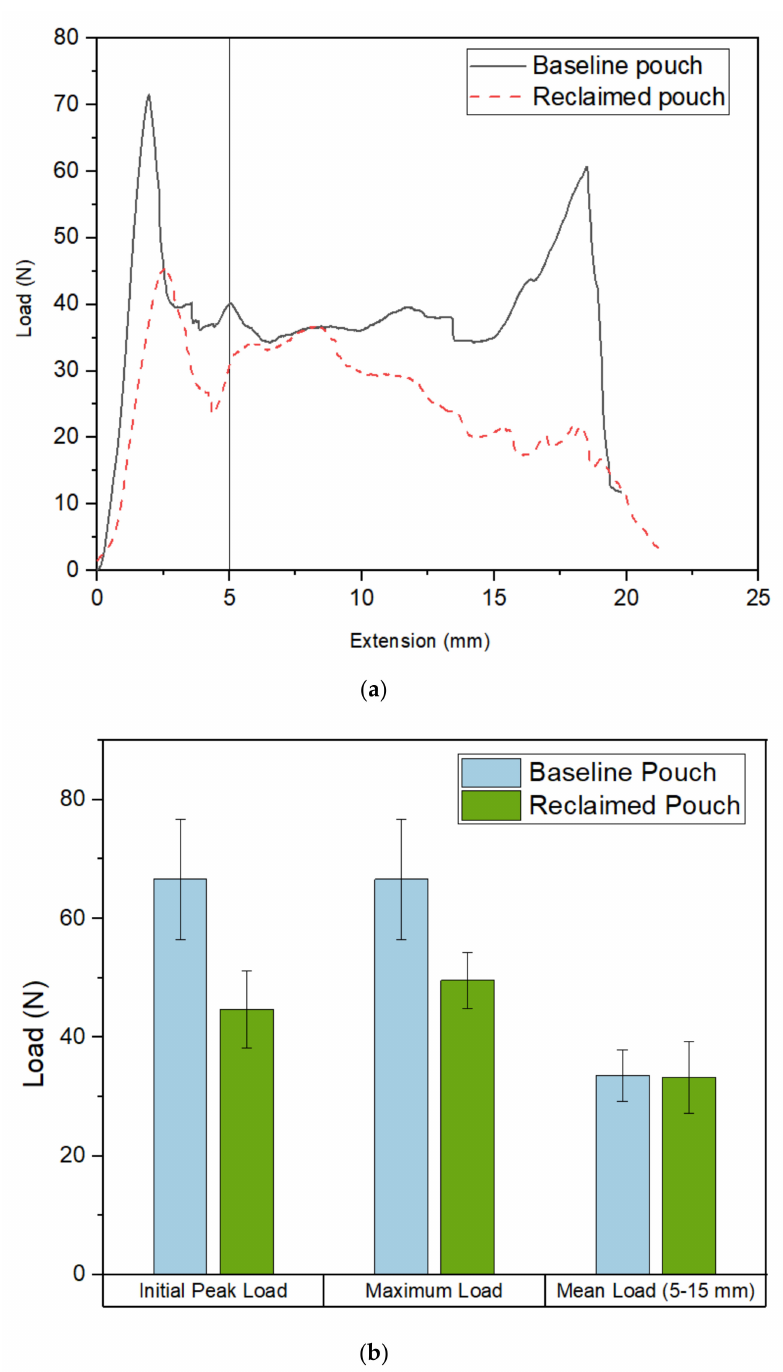
Figure 10. Graphs to show load vs extension curves for a number of pouch specimens. ( a ) Gives an example load vs extension graph for a baseline pouch compared to a reclaimed pouch. We see an initial peak load below 5 mm and then the graph appears flatter between 5–15 mm. ( b ) compares the average peak load, maximum load and mean load over a number of baseline and reclaimed